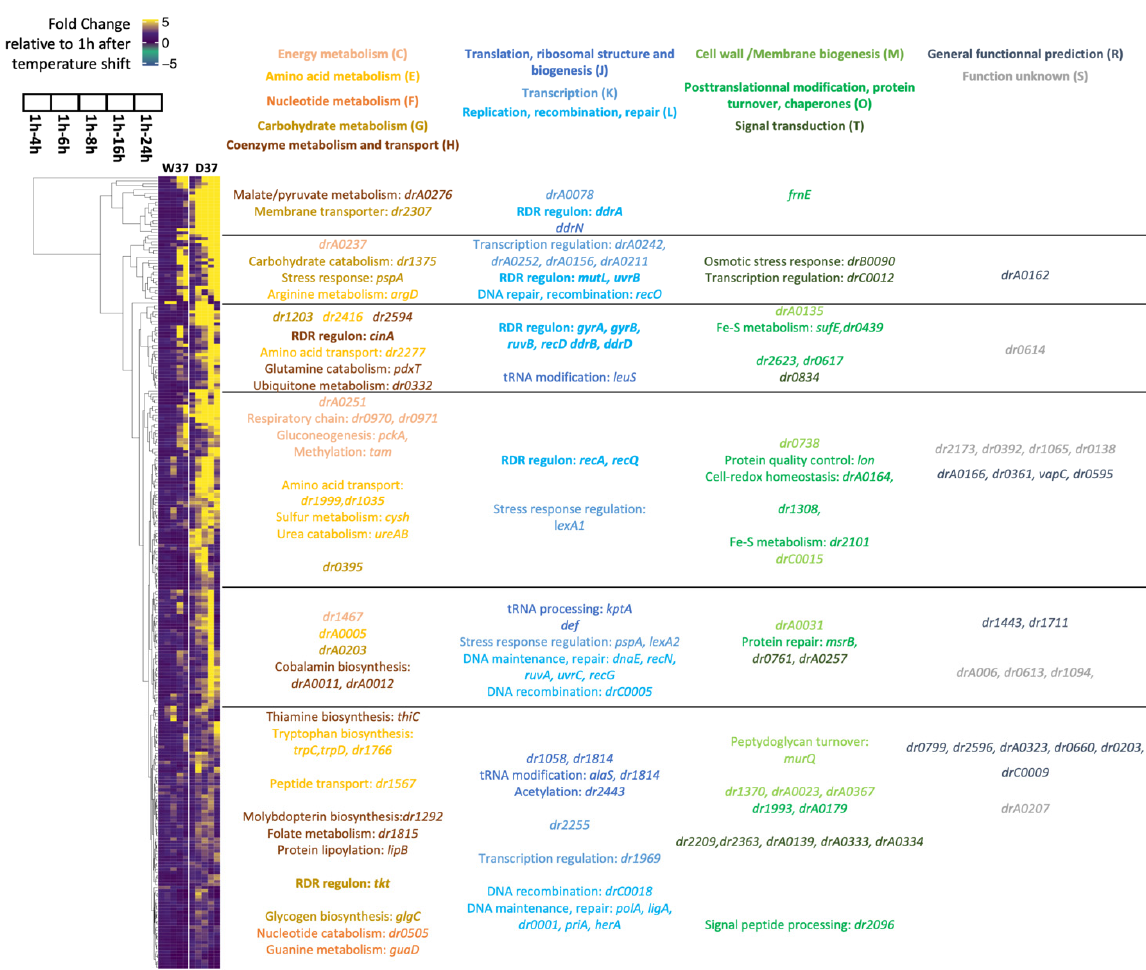
Figure 6. Hierarchical clustering of genes specifically upregulated in response to DdrO depletion. The 260 genes differentially expressed in the time periods 1–6 h and 1–16 h in the W37 strain in two or fewer comparisons (DE ≤ 2) and in more than three comparisons in the D37 strain (DE > 3) were hierarchically clustered according to their temporal expression. Only several genes representing some COG categories are shown.